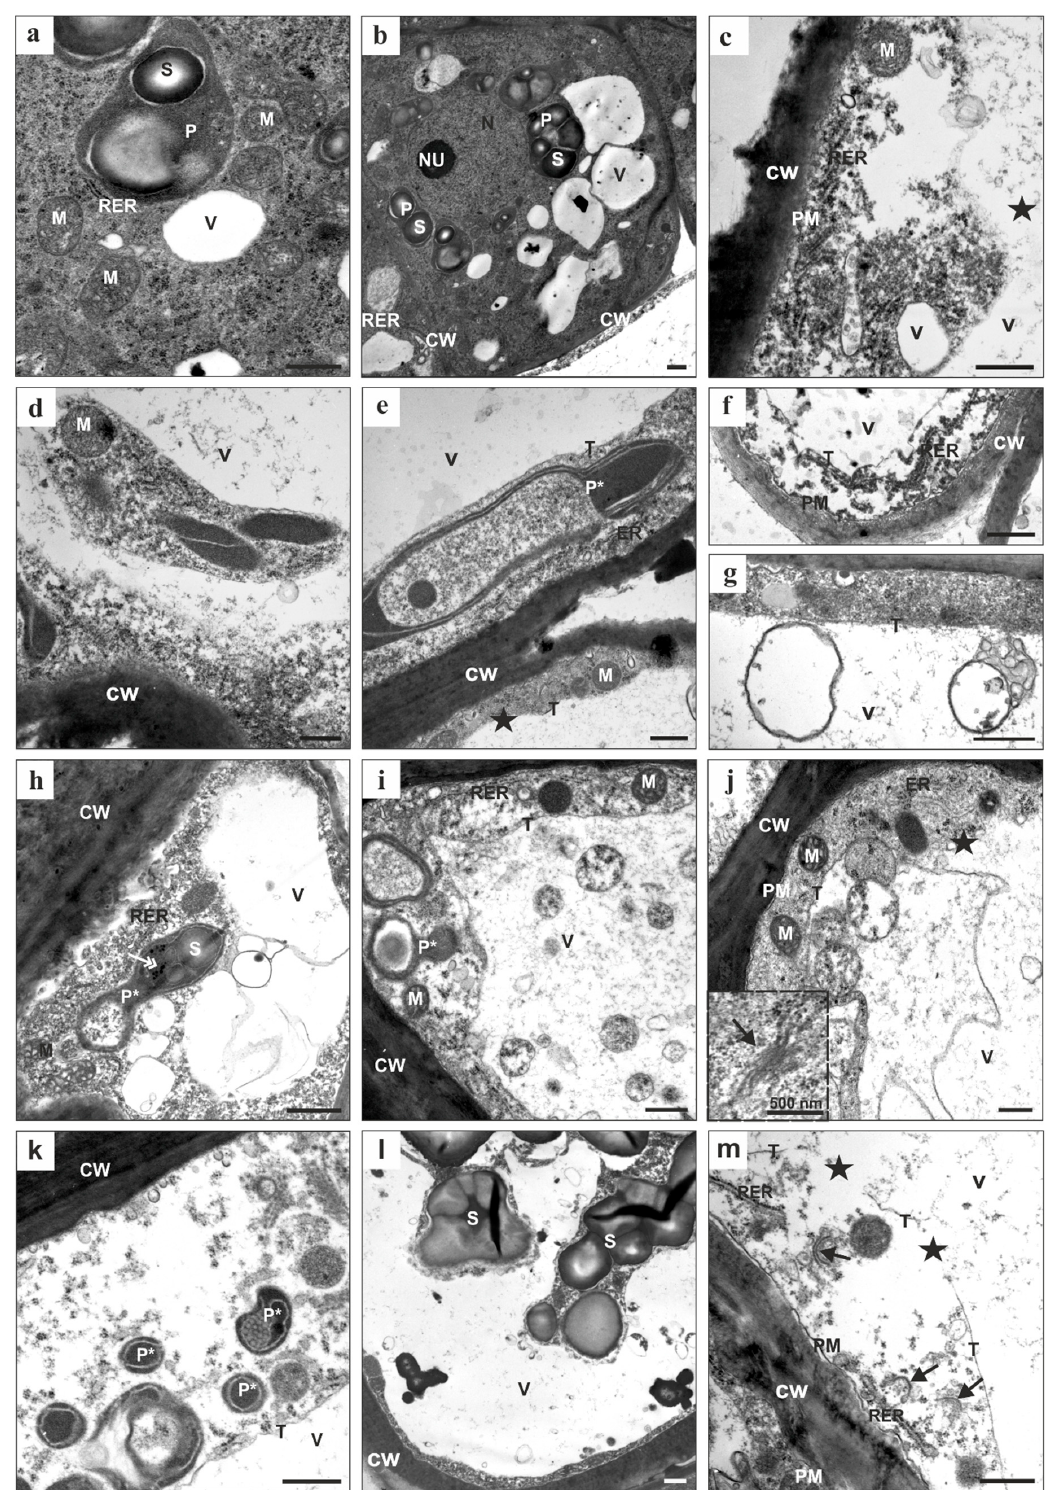
Figure 2. Callus cell ultrastructure in the control ( a – b ) and in the callus that has been treated with 5 µM ( c – f ) and 50 µM ( g – m ) of 5-azaC. CW: cell wall; ER: endoplasmic reticulum; M: mitochondria; N: nucleus; NU: nucleolus; P: plastid; P*: plastid with an altered ultrastructure; PM: plasma membrane; RER: rough endoplasmic reticulum; S: starch; T: tonoplast; V: vacuole; arrows: dictyosomes of Golgi apparatus; double arrow: plastoglobules; asterisks: tonoplast breakdown. Scale bars, 1 µm.